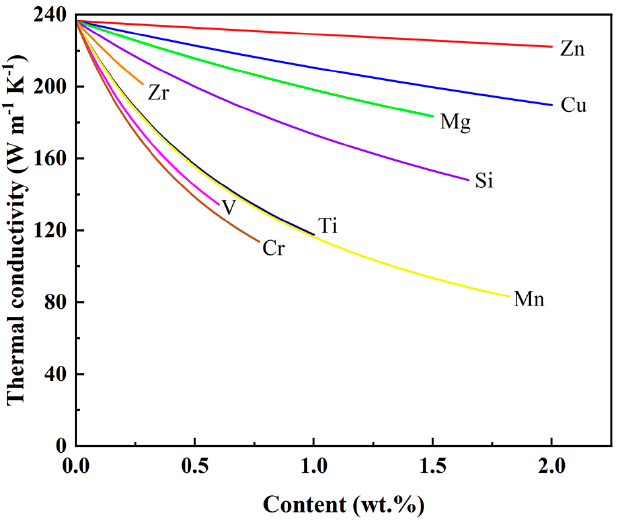
Figure 1. The relationship between the thermal conductivity of aluminum and the content of solid solution alloying elements [61].